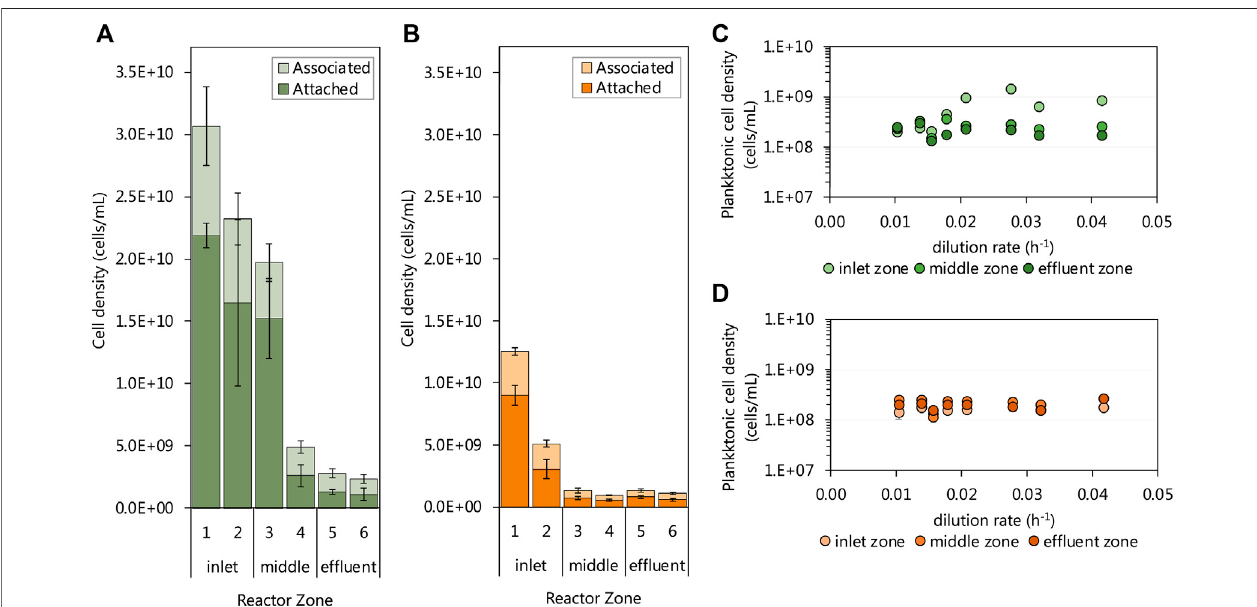
FIGURE6| Thecelldensitiesofthebio fi lm-associatedand-attachedcommunitiesthroughoutthesix0.167 Lsubzonesofthe (A) lactateand (B) acetateUAPBRs atsteady-stateataone-dayHRT.Thesteady-stateplanktoniccelldensitiesfromthe (C) lactateand (D) acetate-supplementedUAPBRsinlet-,middleandef fl uentzones are shown at each tested dilution rate. Error bars represent one standard deviation from the mean with sampling performed in duplicate and each counted in duplicate.